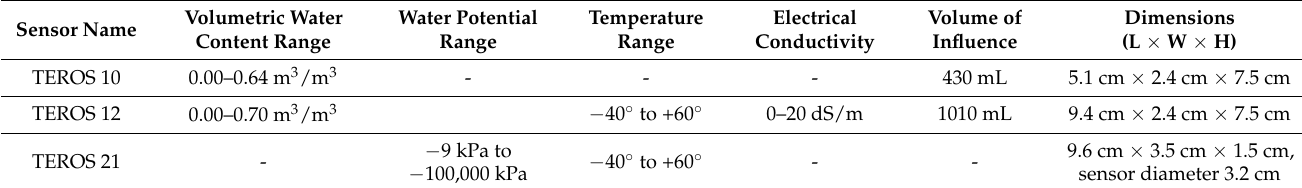
Table 6. Characteristics of the TEROS soil moisture and potential